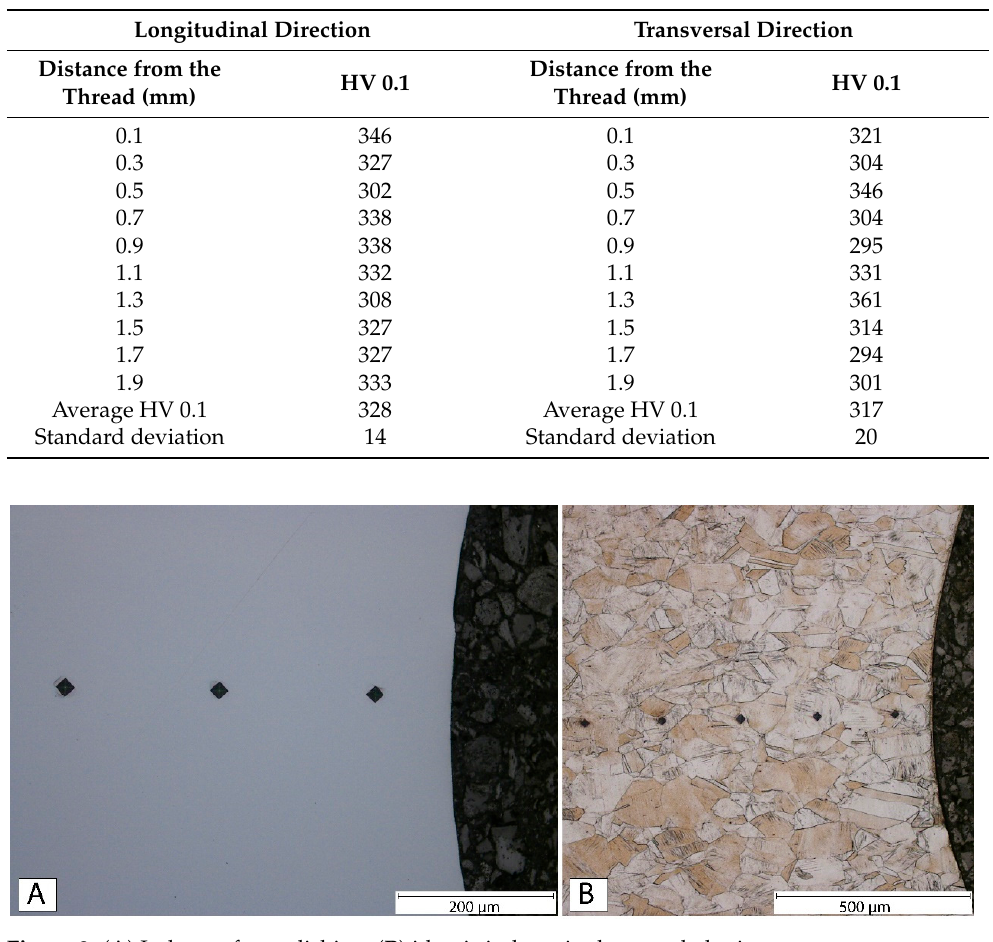
Figure 3. ( A ) Indents after polishing, ( B ) identic indents in the revealed microstructure.